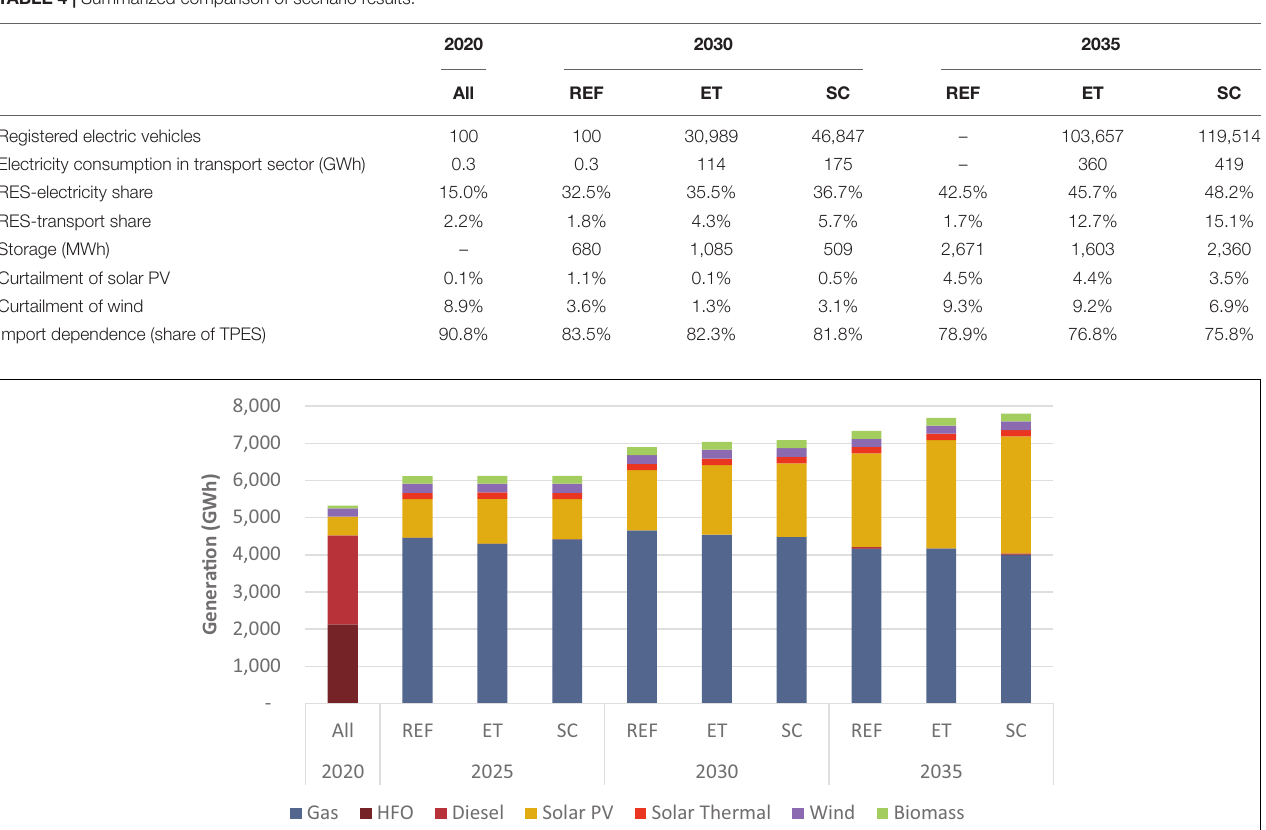
TABLE 4 | Summarized comparison of scenario results.